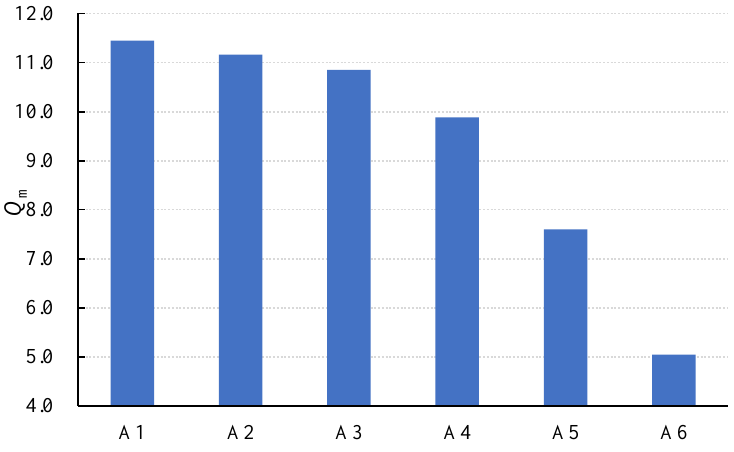
Figure 8. Changes in Qm of specimens with SL/FA.